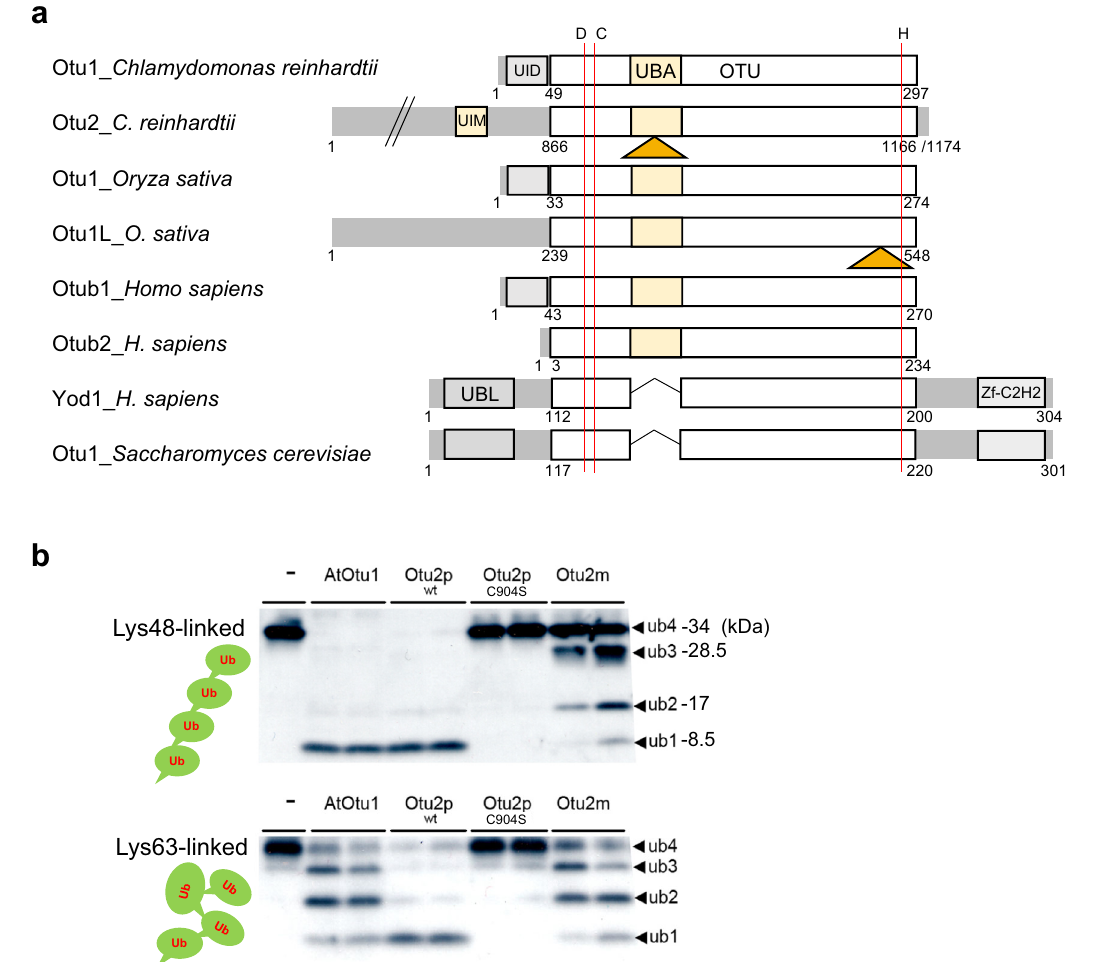
Fig. 3 The deubiquitinase Otu2p protects TOCs from degradation during gametogenesis. a Schematic domain structure of OTUB (protease C65) family deubiquitinases (DUBs). OTUB family members are distinguished by a UBA (ubiquitin-associated) domain in the catalytic OTU domain and lack N-terminal UBL (UBX-like) and C-terminal zf-C2H2 domains conserved among OTUD proteins. OTU2 encodes an 1166 or 1174 amino acid (aa) protein with a C-terminal OTU domain. Otu2 homologs include a unique loop (orange triangle, 55 aa-long in C. reinhardtii ) within the UBA domain. The predicted catalytic triad (vertical red lines; D901, C904, and H1151 in Otu2_ C. reinhardtii ) is conserved in OTUB and OTUD. Divergent OTUB family proteins in monocotyledonous plants (Otu1L) and mammals (Otub2), but lack the N-terminal UID domain known to interact with E2 enzymes. A ubiquitin-interacting motif (UIM) is found in Otu2 homologs. b In vitro deubiquitinase activity assay for the otubain domain of Otu2. The deubiquitinase activity against the tetra-ubiquitin substrates in Lys48-linked and Lys63-linked forms was examined by SDS-PAGE and immunoblot analysis using an anti-ubiquitin antibody. The in vitro deubiquitinase reaction was incubated for 30 min at 37 °C with 50 ng proteins. The C-terminal otubain domains of Otu2p, Otu2pC904S, and Otu2m proteins as well as the full-length Arabidopsis Otu1 (AtOtu1) proteins were produced in E. coli and puri fi ed by N-terminal 6x His-tag. The assay was repeated more than three times with technical